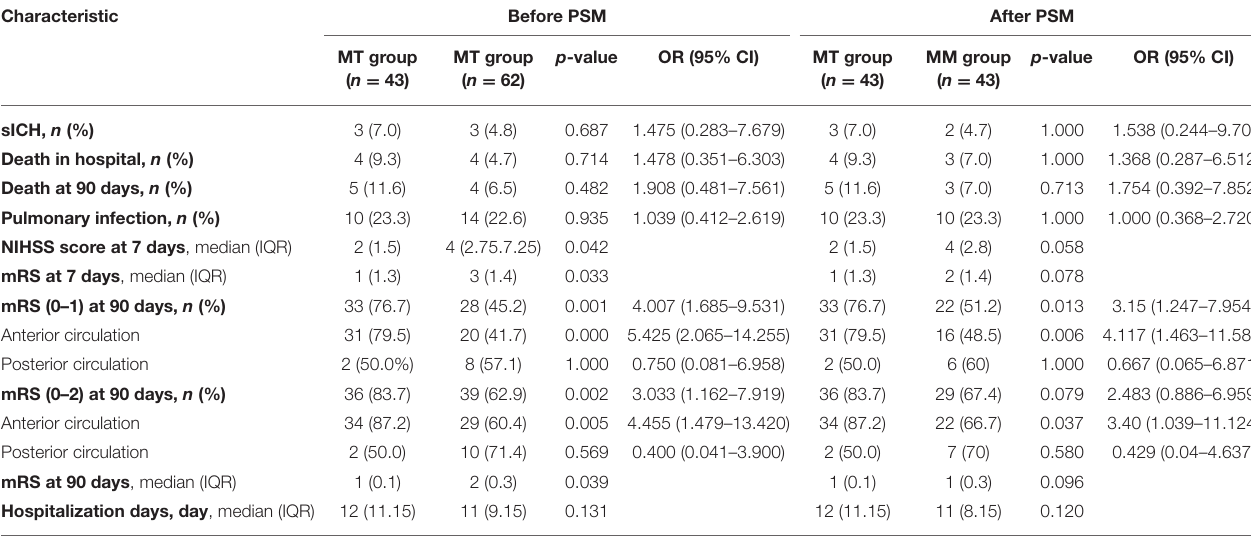
TABLE 2 | Clinical outcomes of patients between thrombectomy and medical management group before and after PSM. Characteristic